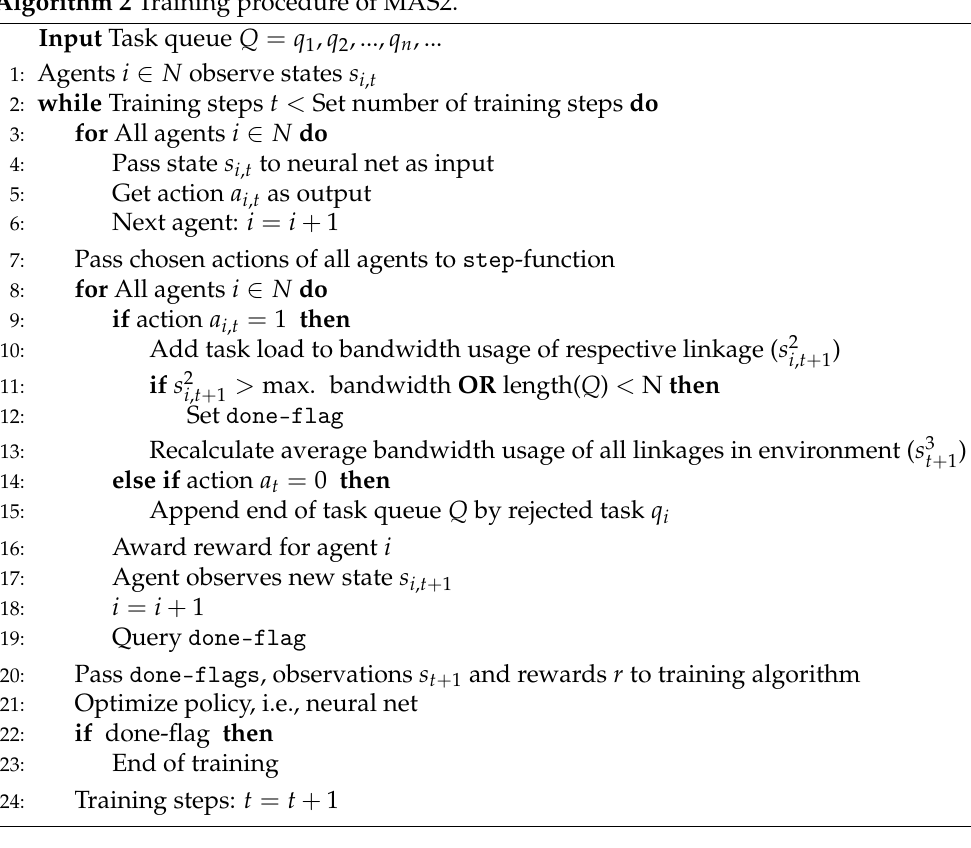
Algorithm 2 Training procedure of